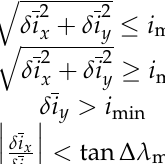
Figure 7. The NSSK in normal working condition. To meet the normal working conditions, the following conditions must be met at the same time: